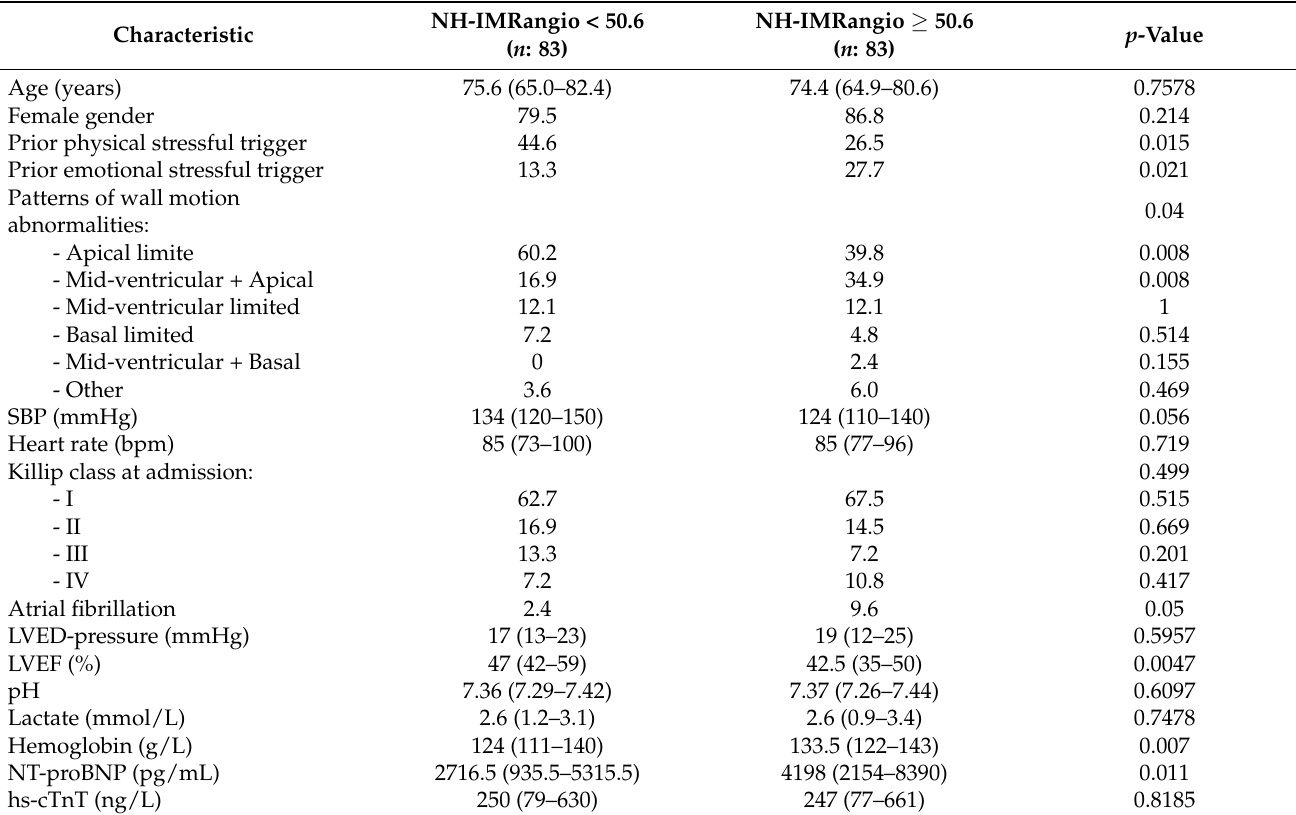
Table 2. Differences between patients based on NH-IMRangio values ( n : 166